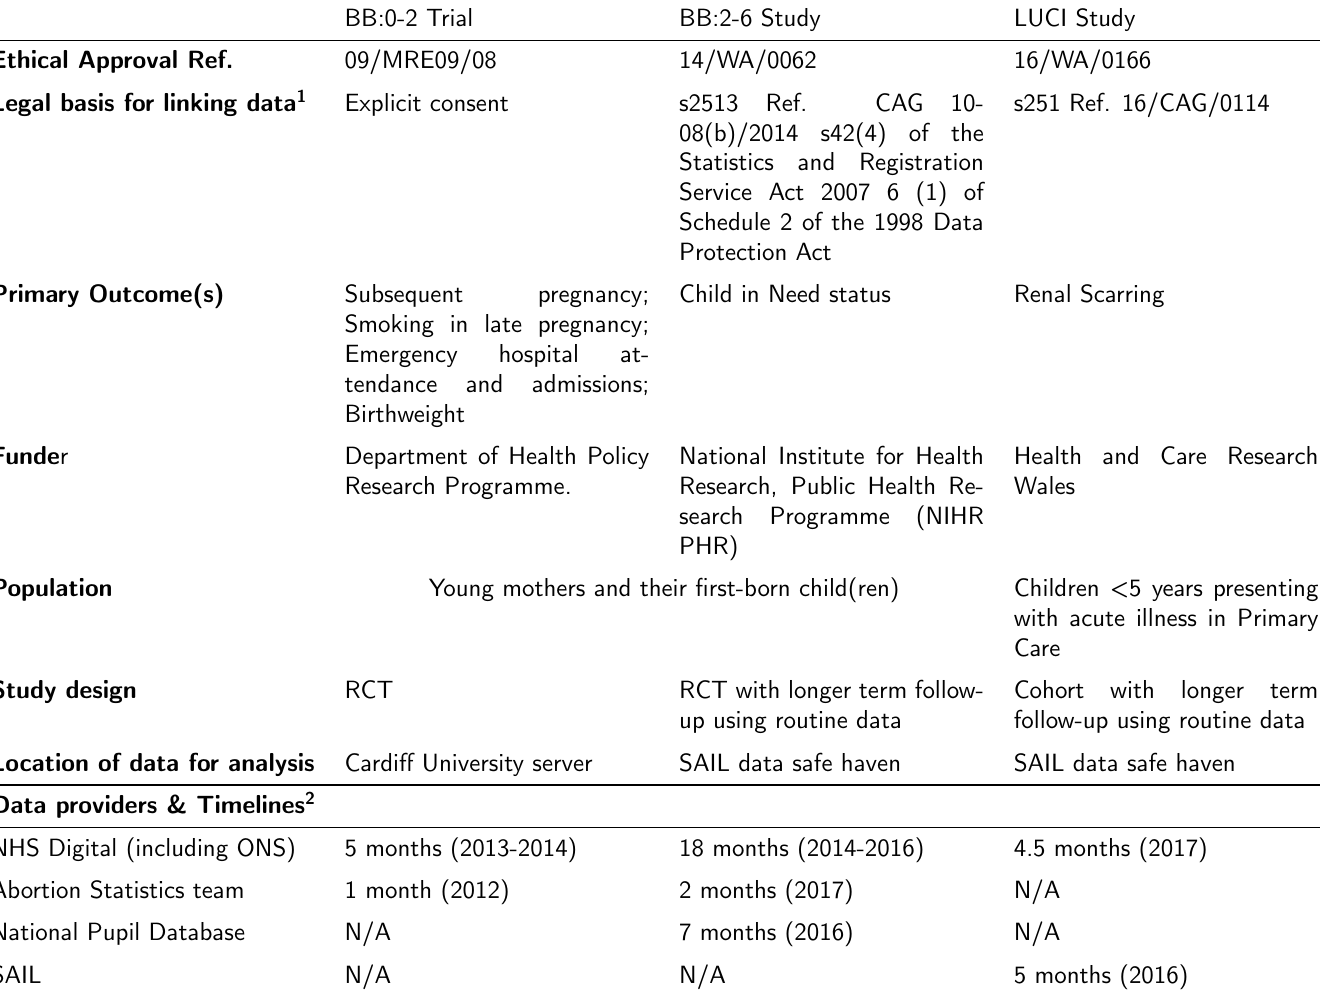
Table 1: A summary of the three case studies – BB:0-2 Trial, BB:2-6 Study and LUCI